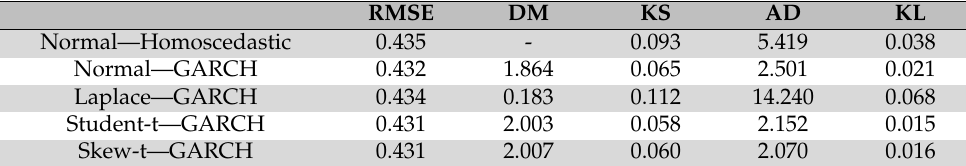
Table A5. Forecast evaluation results—real